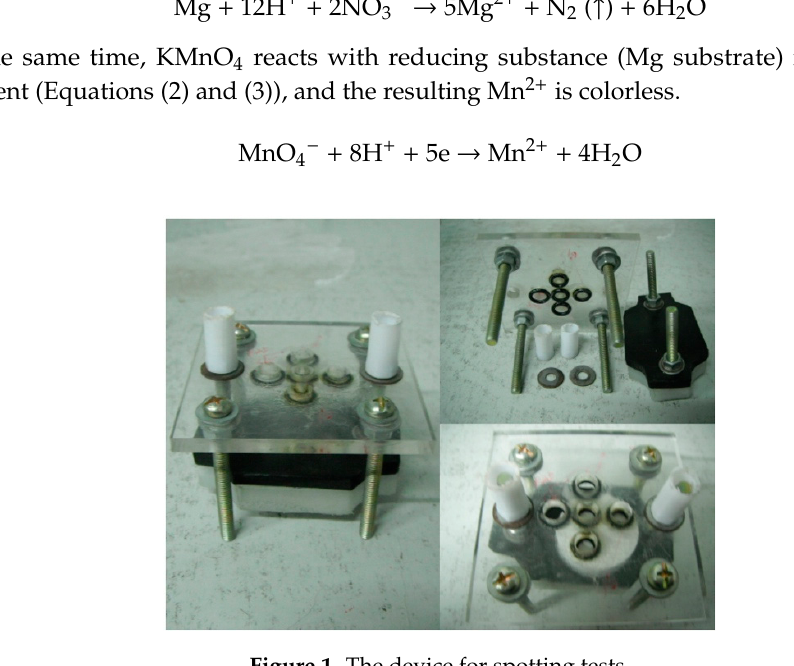
Figure 1. The device for spotting tests.